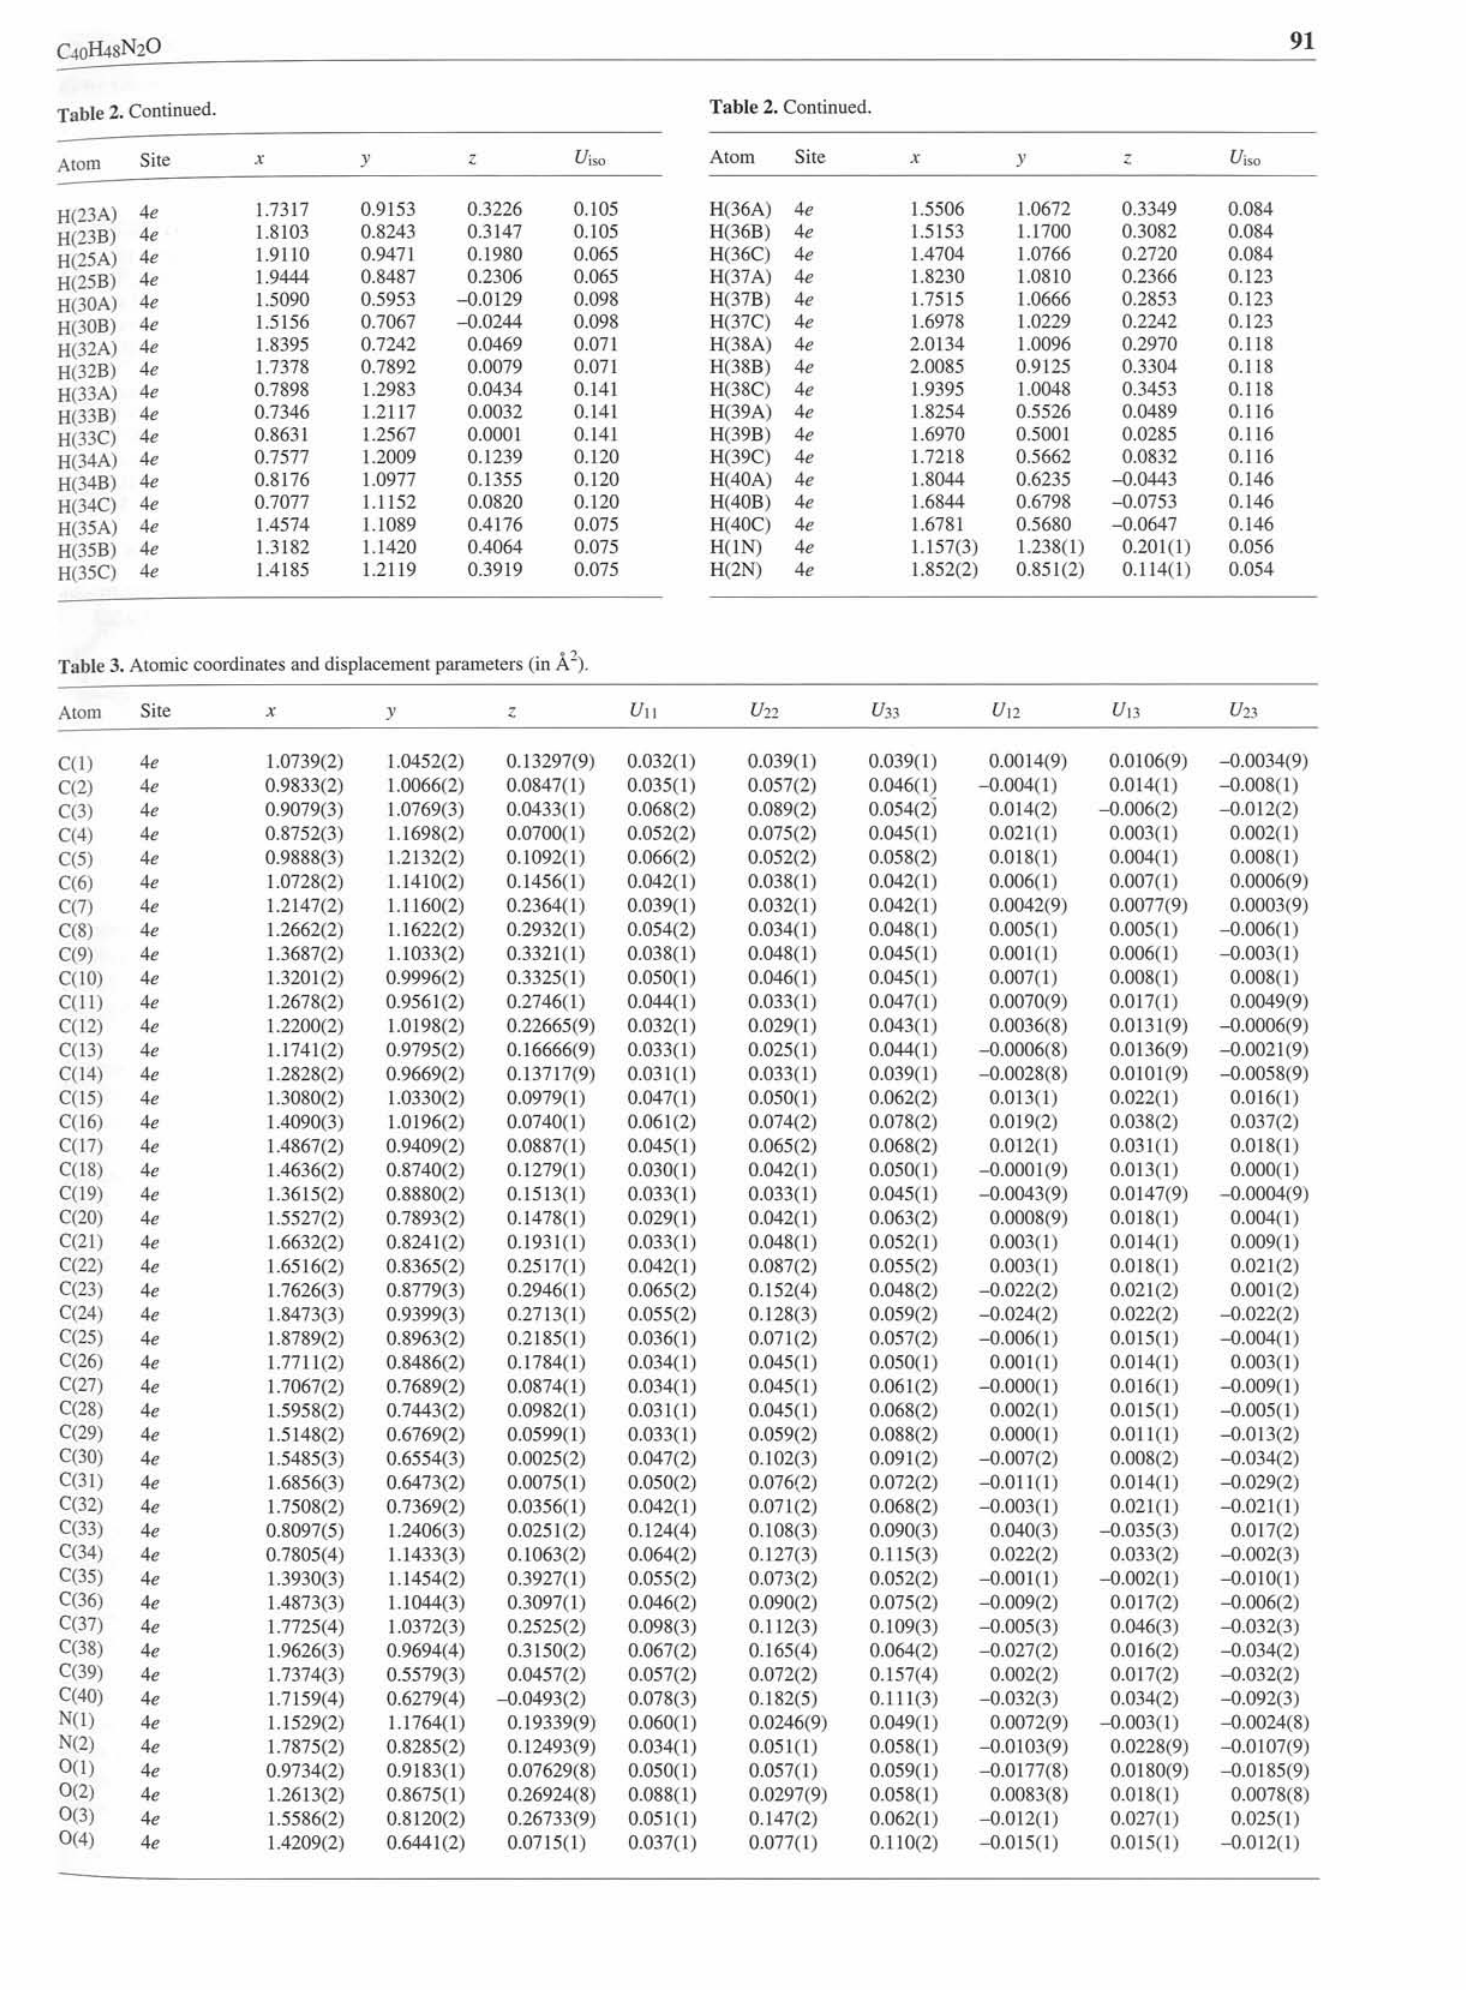
Table 3. Atomic coordinates and displacement parameters (in À 2